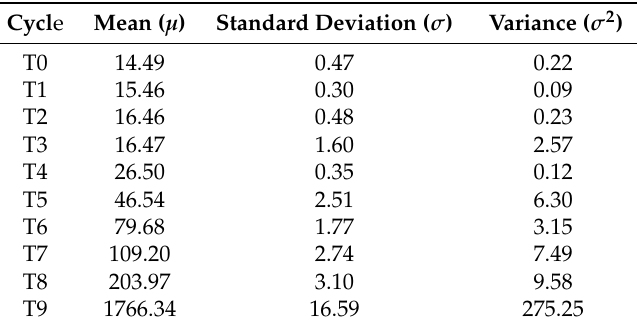
Table 4. Centralized cloud server results (seconds).